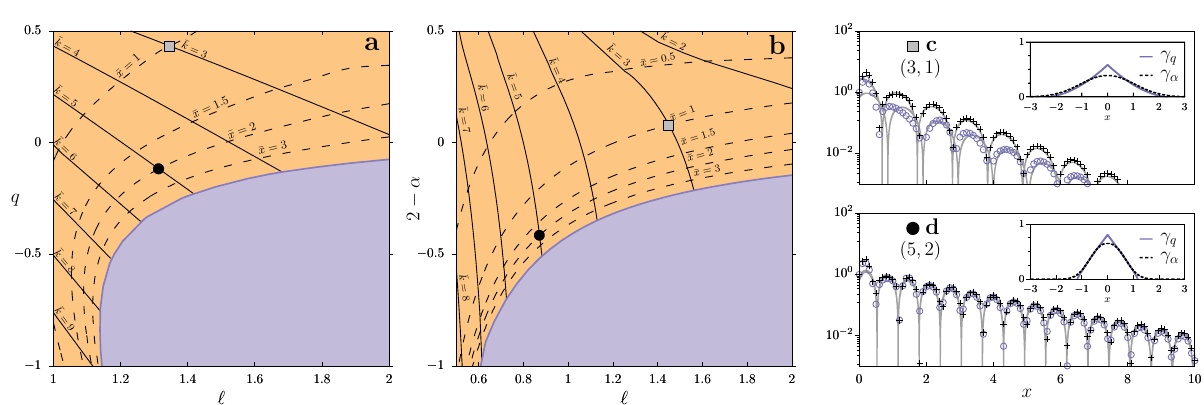
Figure 7. Long-time spatial distribution in 2D. Simulated scenarios: ( a ) a circular region (with radius 5 a.u., highlighted with a black dashed boundary) where the growth rate is positive, a (in a strong negative background a A ); ( b ) a circular region (with radius 2.5 a.u., highlighted with a black dashed boundary) where the growth − A (while outside, it is positive, a ); ( c ) four regions with negative growth rates a is strongly negative a − a positive background, a ); ( d ) time-independent random landscape (where each spatial cell is assigned a growth rate uniformly distributed in [0.5 a , 1.5 a ]). In all cases the interaction kernel is γ q , with ℓ 3 , a 10 1 and A 10 . Colors show the deviation from the homogeneous state ρ( x , t ) D b − = = = = 1 for the chosen values of the parameters). For numerical integration, a pseudo-spectral method 45 was ρ 0 = 3 . 0.2 and (cid:31) t 10 used with (cid:31) x − = =